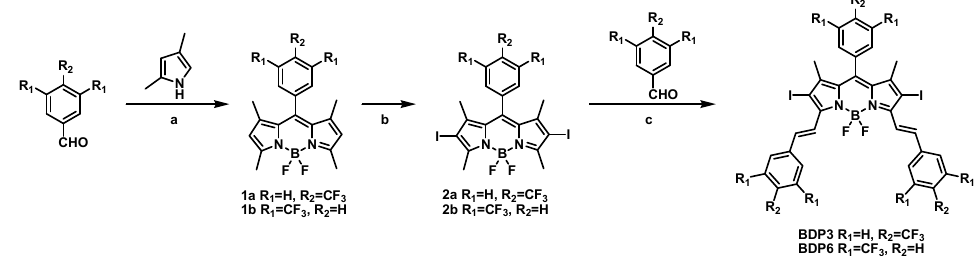
Scheme Scheme 1. Synthetic route of BDP3 and BDP6 . a: (1) TFA, CH 2 Cl 2 (2) 2,3-dichloro-5,6-dicyano- p -